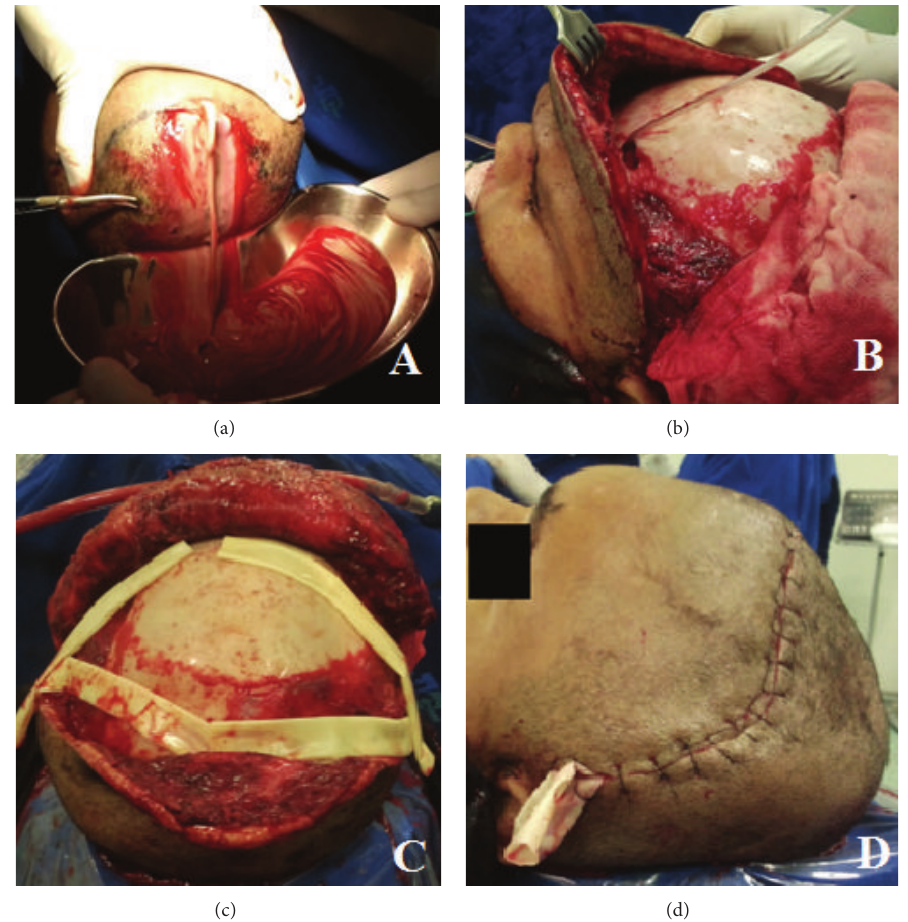
Figure 3: Intraoperative images. Thick purulent secretion (a). Erosion of the outer table of the frontal bone, necrosis of the temporal muscle and frontal sinus combined approach surgery (b). Penroses drains placed (c). Final appearance after suture of bicoronal incision